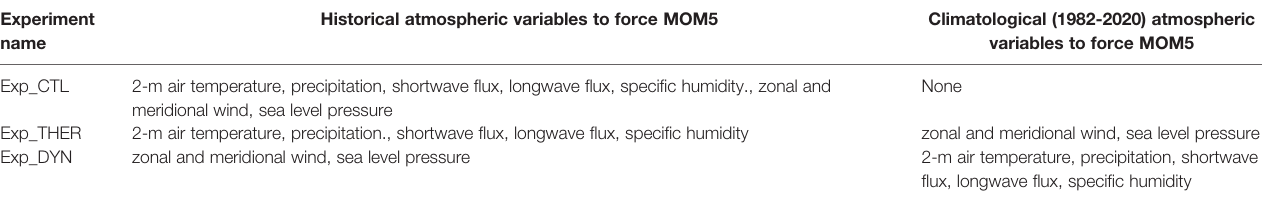
TABLE 1 | Time scales of atmospheric forcing variables used in the three